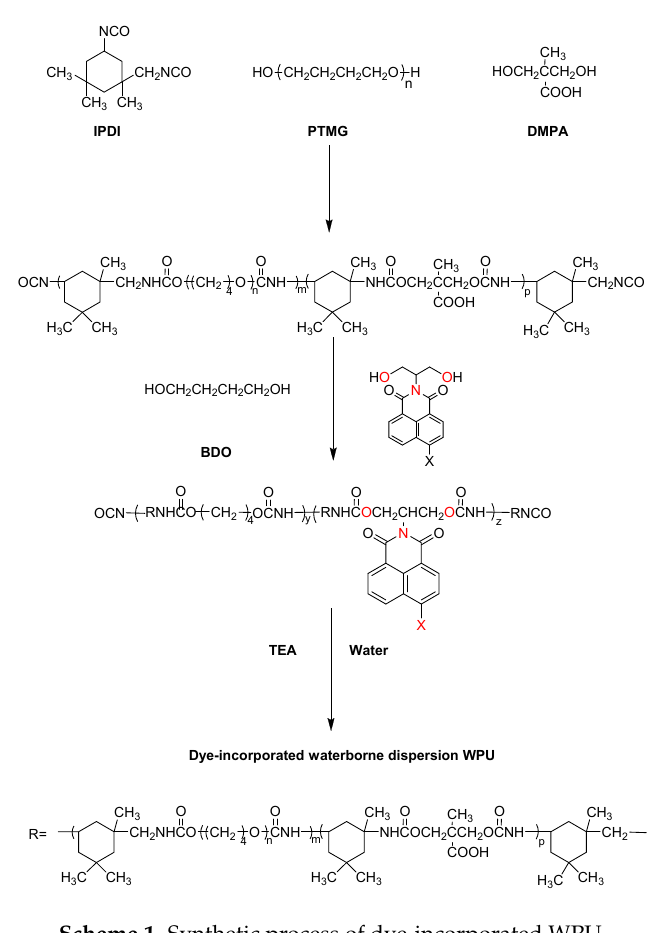
Scheme 1. Synthetic process of dye-incorporated WPU.